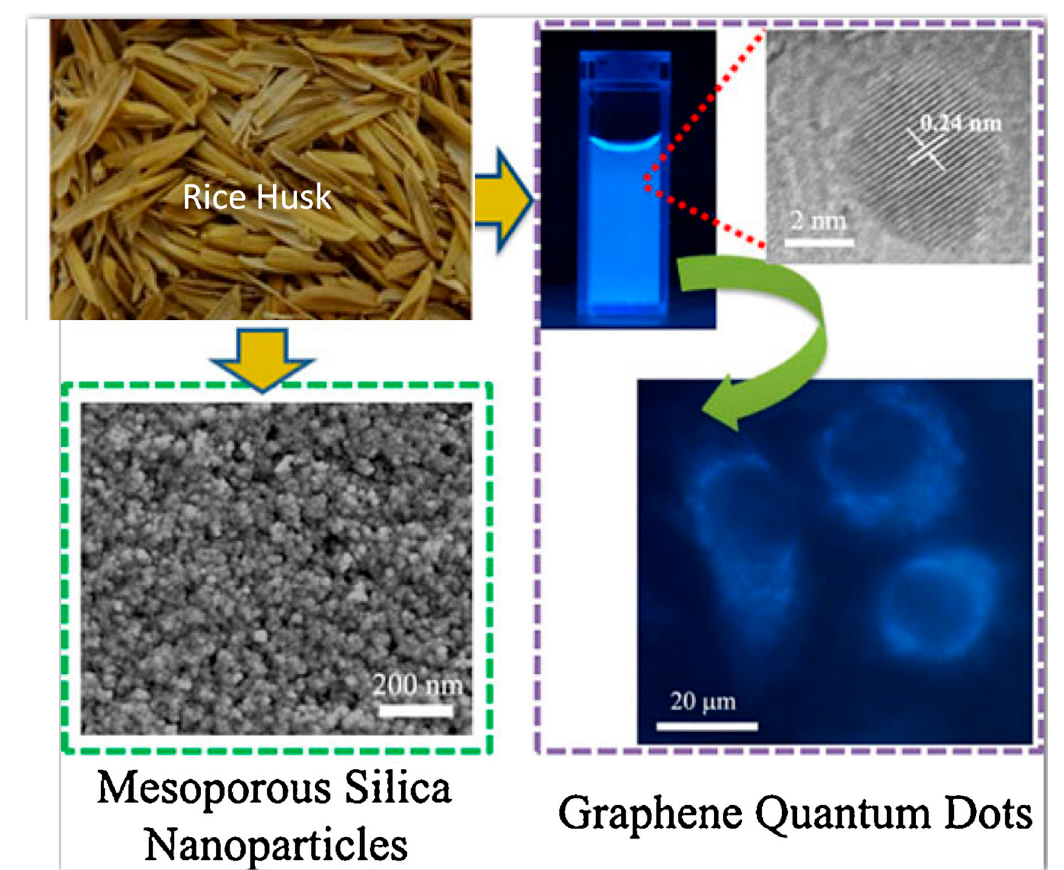
Figure 2. Utilization of rice husk for the preparation of graphene quantum dots Reprinted with permission from ref. [33] Copyright 2016 American Chemical Society.